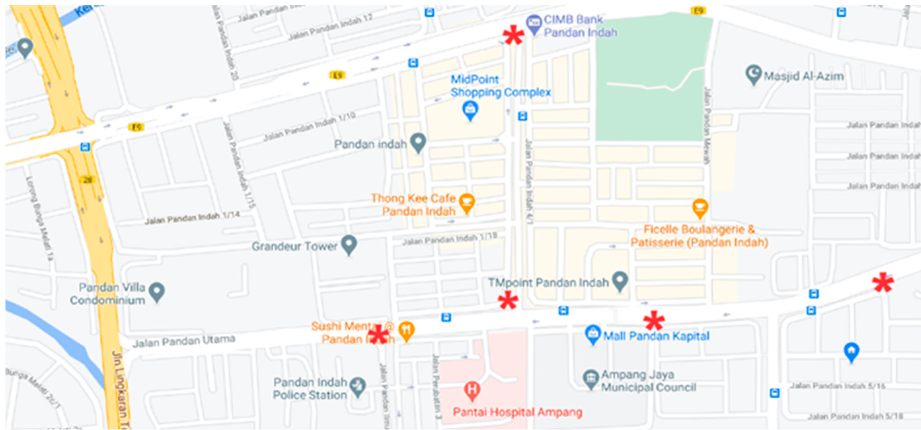
Figure 3. Stationary field-testing locations. The red star indicates the exact position where the prototype was deployed. (Source: Google Maps available at https://www.google.com/maps/place/Pandan+Indah,+Kuala+Lumpur,+Selangor/@3.1311177,101.7523725,16z/data=!4m5!3m4!1s0x31cc365f86dd4897:0xdb6d184b895e07c7!8m2!3d3.133892!4d101.7516751, accessed on 10 November 2020).